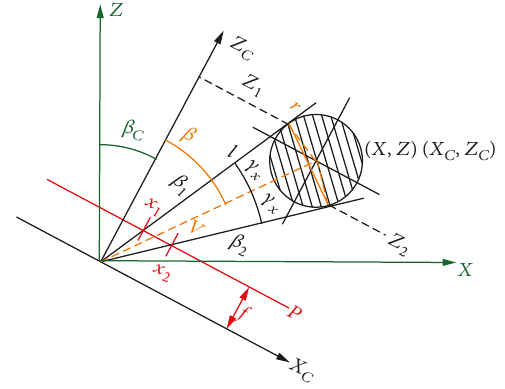
Figure 2: De fi ne t closest position of the intruder).